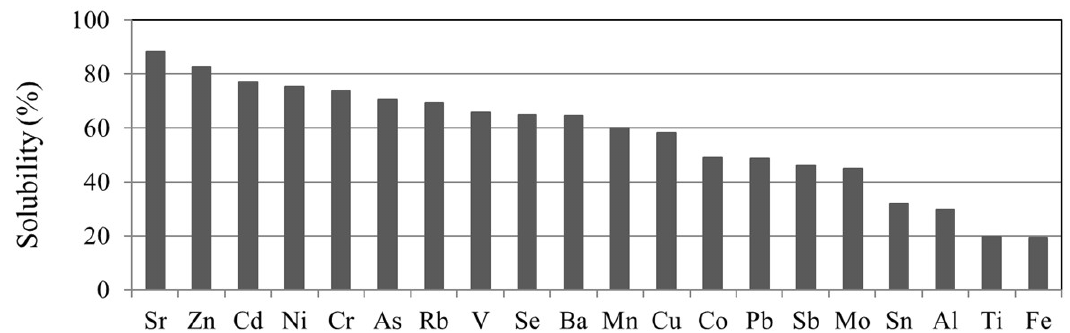
Figure 8. Average solubility of the trace metals in rainwater.